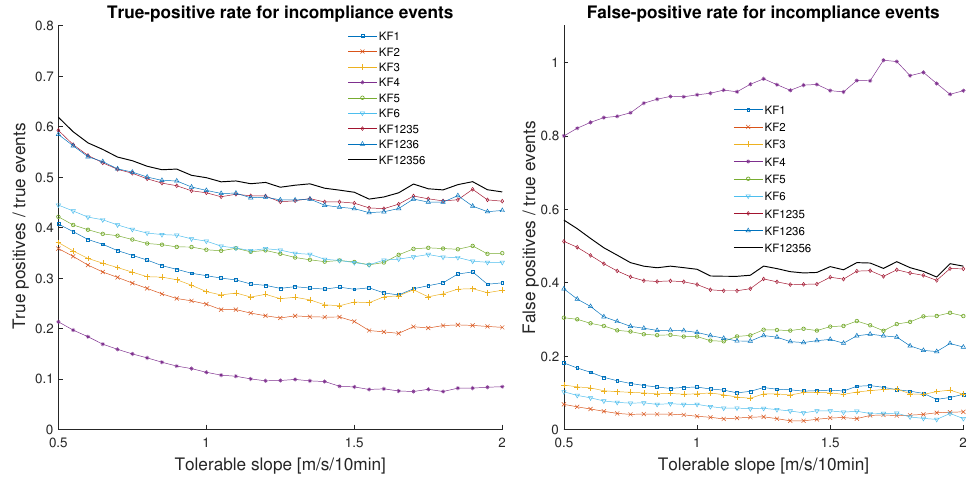
Figure 9. Performance of all forecast methods for the detection of incompliance events two time steps (2 × 10 min) into the future. Left : True-positive rate vs. the critical slope a . Right : False-positive rate vs. the critical slope a